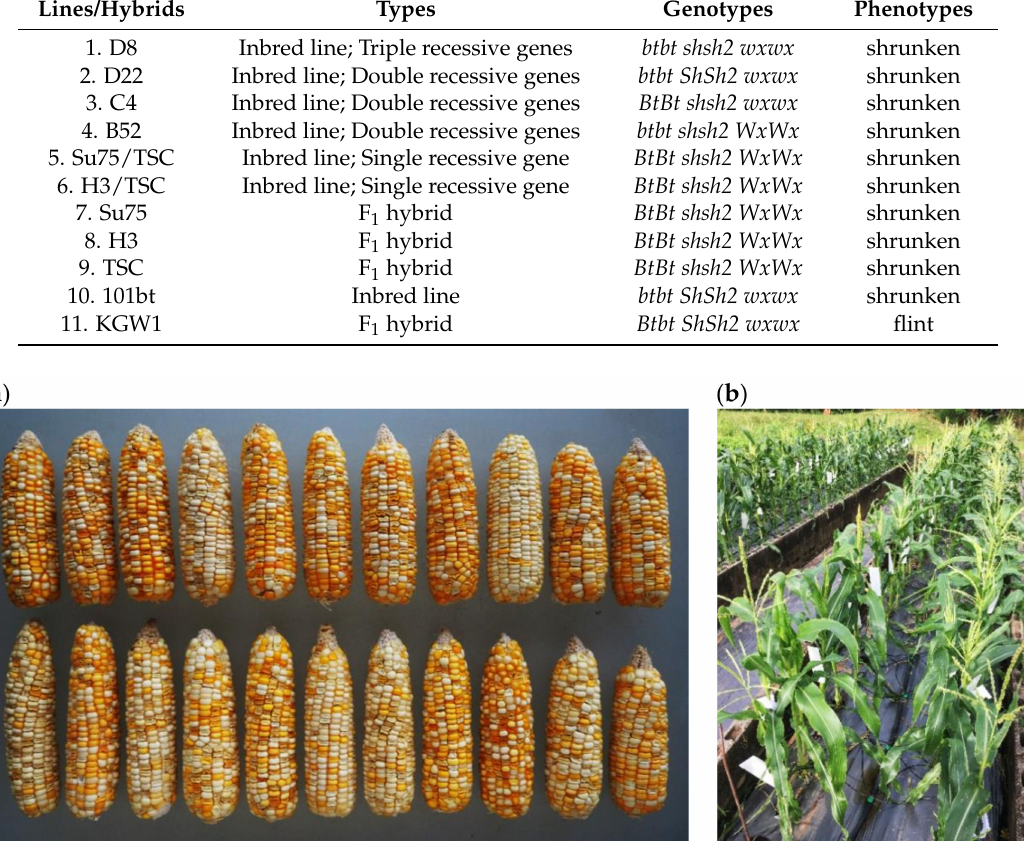
Figure 1. ( a )The ears of the F 2 population used for development of sweet corn inbred lines and ( b ) plants of some sweet corn genotypes in crossing